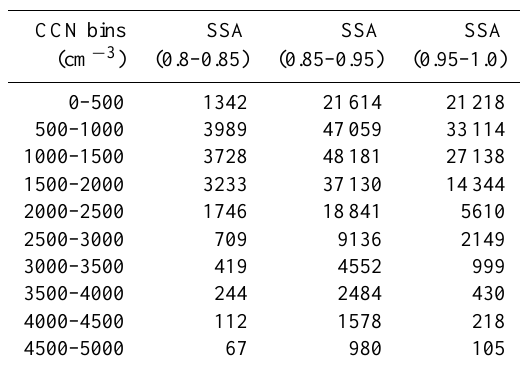
Table 5. Sample sizes for the data points in Fig.